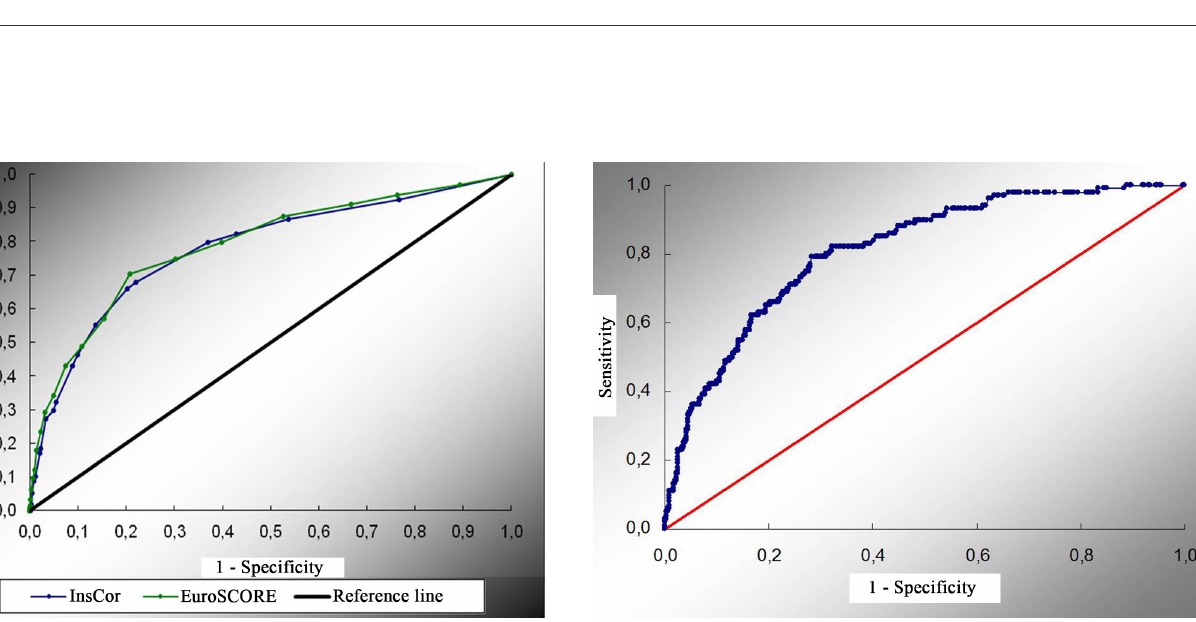
Fig. 2 - ROC curve for EuroSCORE II 0.81 [95% CI (0.77 to 0.85), P<0.001] in the evaluation of the power of discrimination performed in 900